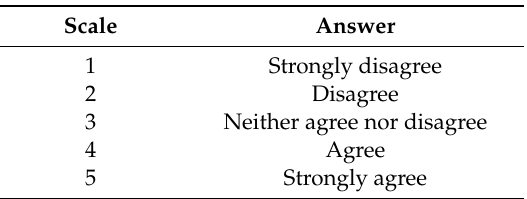
Table 1. Likert scale.